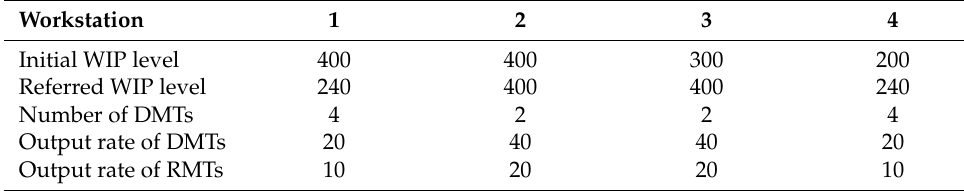
Table 2. Simulation settings of the case study